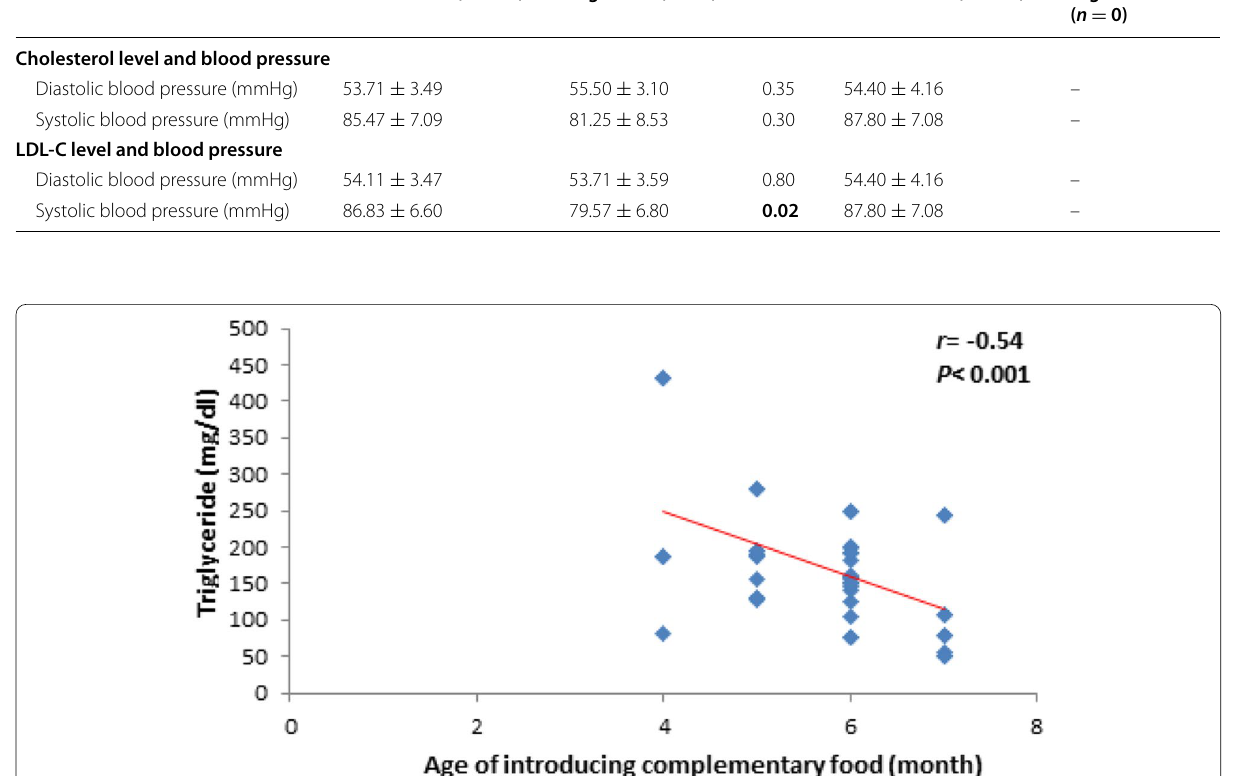
Fig. 1 Correlation between age of introducing complementary food and triglyceride in the breastfed